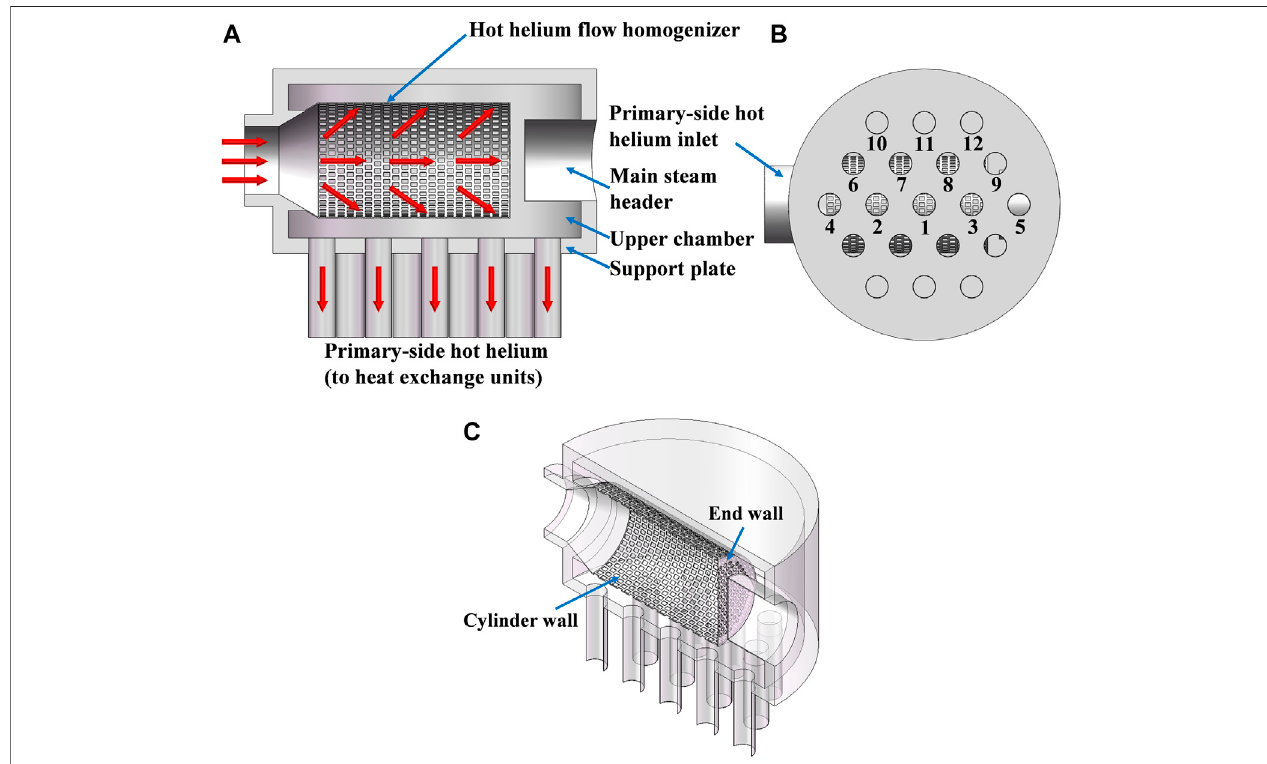
FIGURE 2 | Schematic of the hot helium fl ow homogenizer. (A) Main view. (B) Bottom view. (C) Perspective